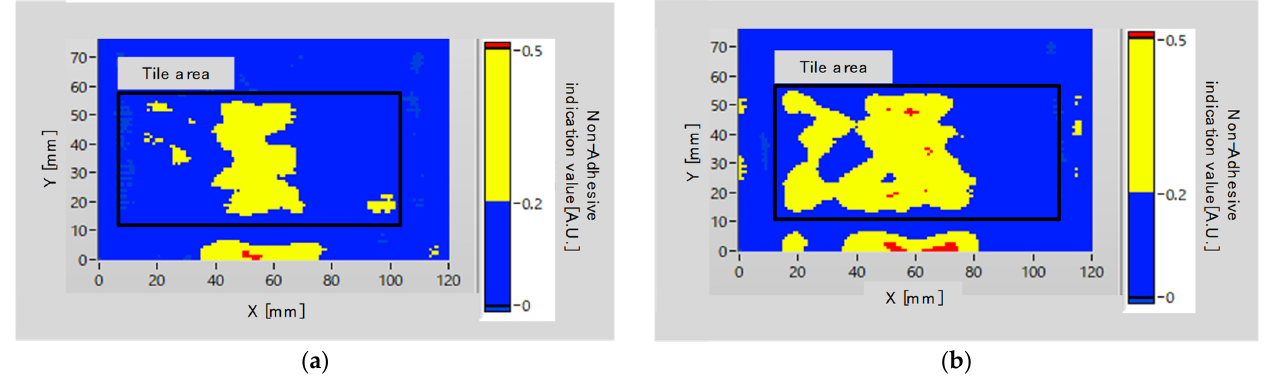
Figure 7. Microwave measurement: ( a ) normal base; ( b ) hollow-type base. In order to verify the results of the microwave measurement, the conventional method was utilized; that is, the tiles were peeled off, and the adhesive surfaces were visually checked and classified into the following three categories for each 5 mm square. a. Non-adhesive state: red dot. b. Half-adhesive state: yellow dot. c. Adhesive state: green dot.